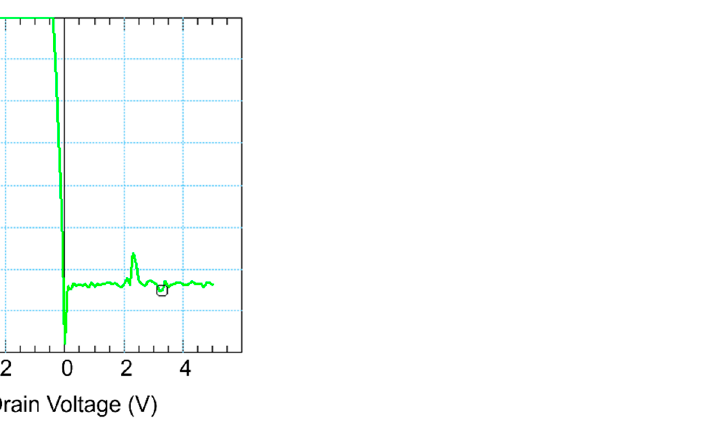
Figure 11. Measurement of the leakage current of the footer NMOS transistor used in the circuit shown in Figure 5.